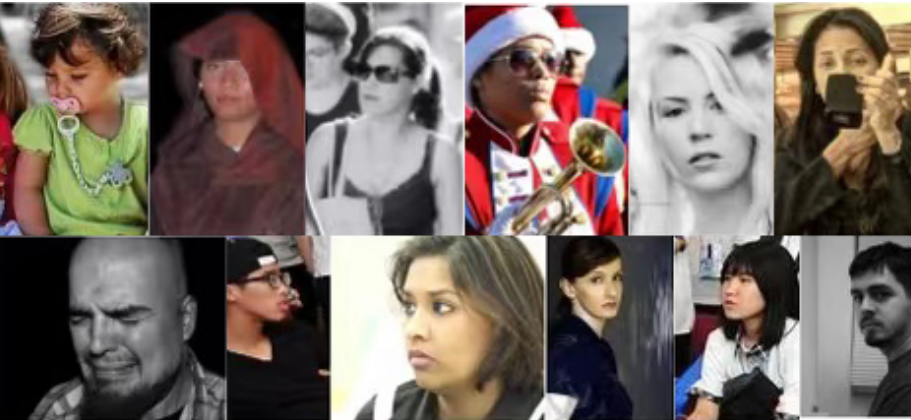
Figure 1. A large-scale facial expression dataset. In the real scene, the location of the face is not fixed. Some faces are at the center of the picture, and some are at the corner of the picture; the pose of the face is uncertain, including 30 ◦ , 45 ◦ , and 90 ◦ faces. Some faces are blocked, some facial features cannot be seen, and the image is unclear, making facial expression recognition